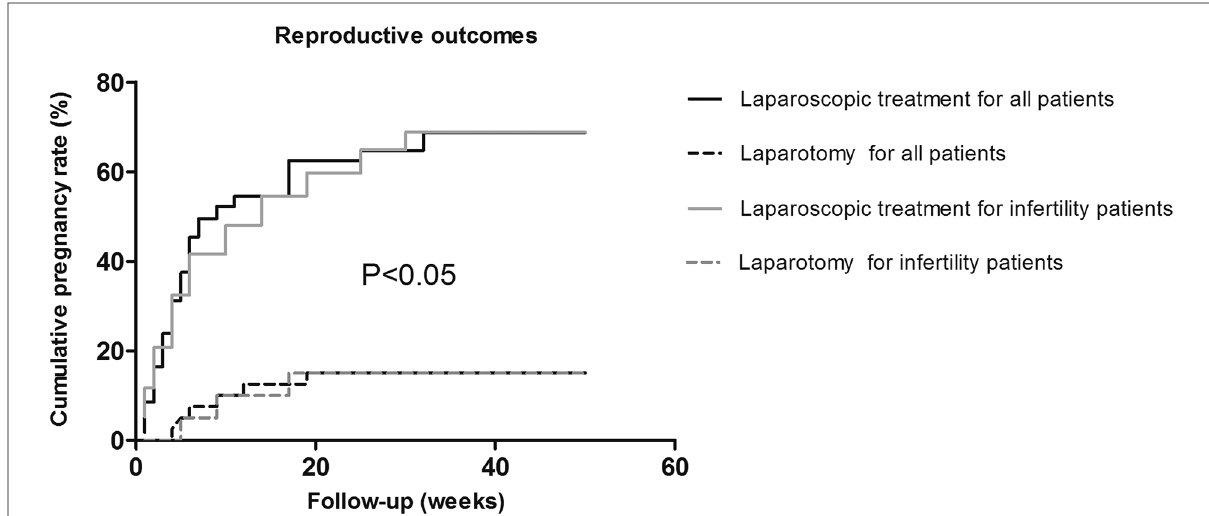
FIGURE 3 The cumulative pregnancy rates in the laparoscopic group and the traditional laparotomy group. Laparoscopic treatment is indicated by a solid black line for all patients and a solid gray line for infertility patients, and laparotomy is indicated by a dashed black line for all patients and a dashed gray line for infertility